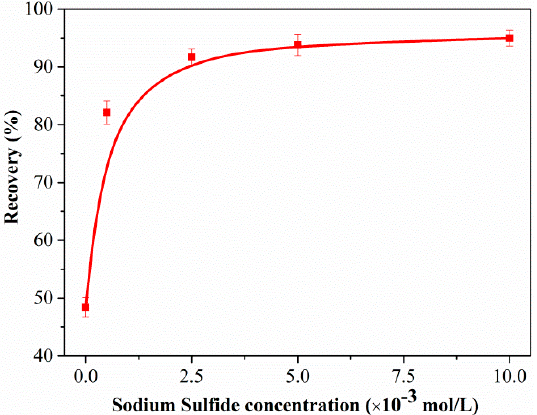
Figure 3. Flotation recovery of smithsonite as a function of Na 2 S concentration C(DDA)= 1.5 × 10 − 3 mol/L, pH=10.3.